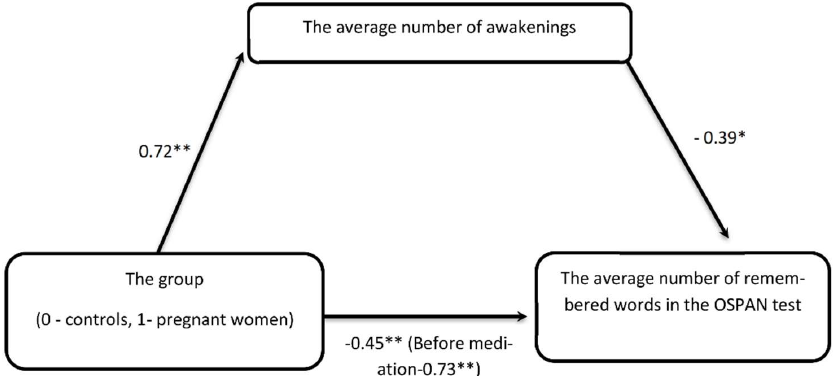
Figure 1. The impact of pregnancy on the OSPAN task is mediated by the average number of awak- enings—the relationship between being pregnant or not, initially very strong, after introducing into the regression model of the intermediate variable in the form of the average number of awakenings is no longer statistically significant. * p < 0.05, ** p < 0.01—statistical significance